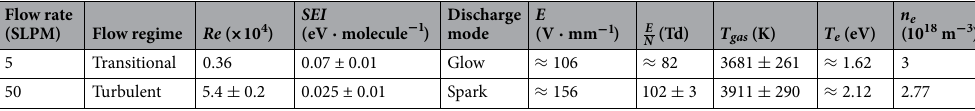
Table 2. Plasma characteristics at the operating